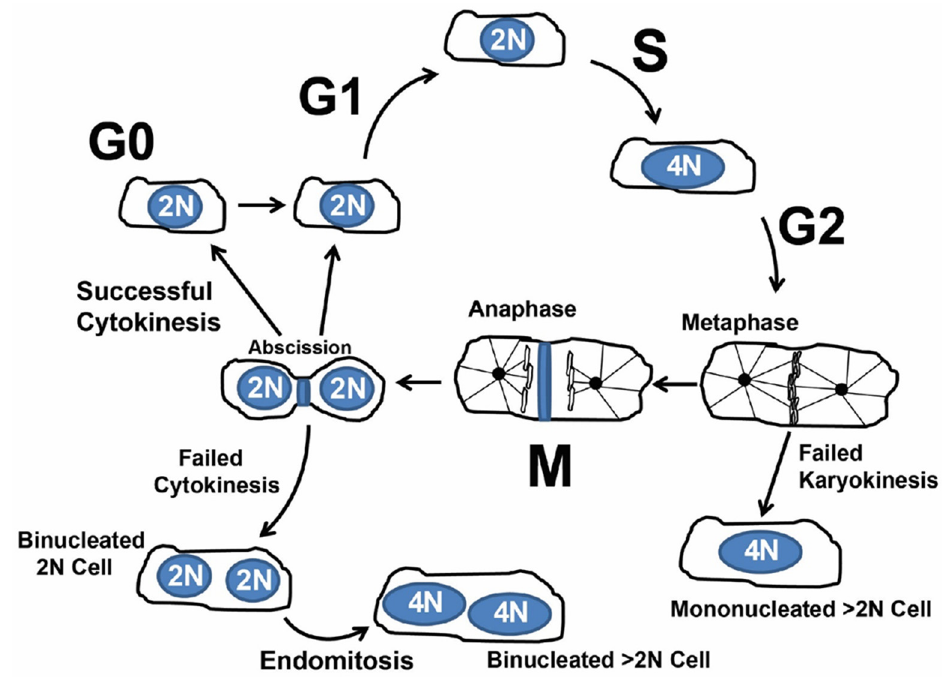
Figure 1. Simplified overview of cardiomyocyte cycling. After G2, failed karyokinesis (nuclear division) produces a single nucleus with >2N genomic DNA content. After mitosis and karyokinesis failed cytokinesis produces a binucleated cell. Further endomitosis of binucleated (on multinucleated) cells produces nuclei with >2N genomic content.